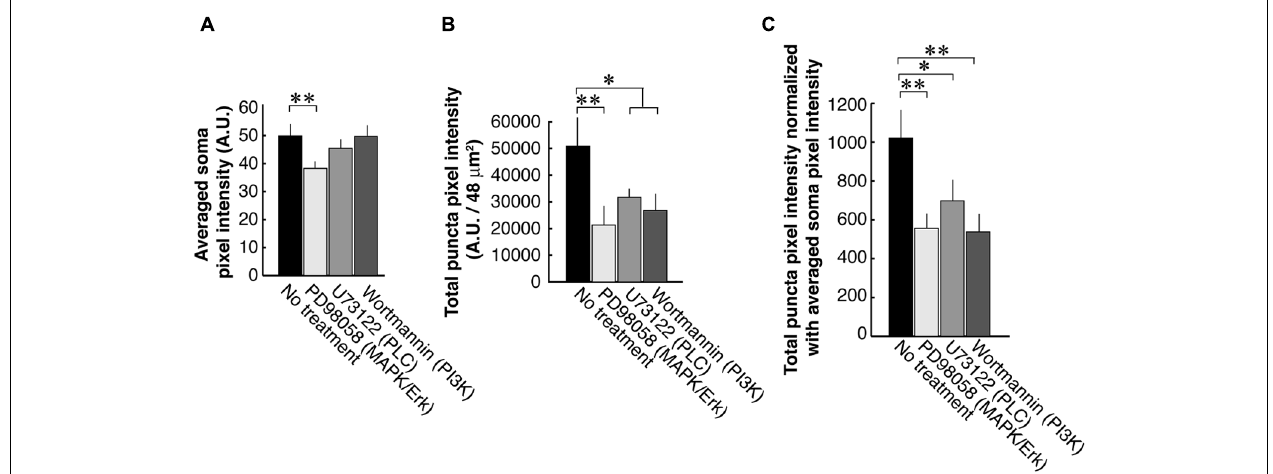
FIGURE 3 | PSD-95 puncta intensities in neurons that are treated with inhibitors of signaling molecules downstream ofTrkB. Neurons are treated with blockers of the PLC (U73122, 1 μ M), MAPK (PD98059, 50 μ M), or PI3K (Wortmannin, 100 nM). Quantification was performed in the same